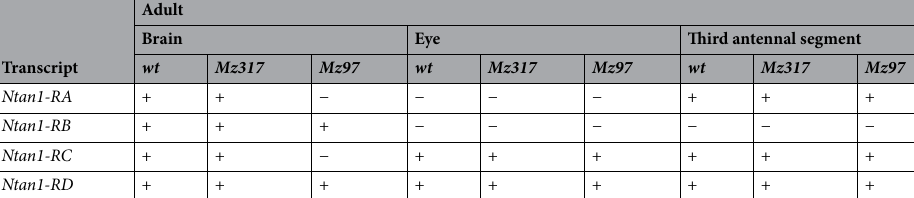
Table 3. Summary of the results obtained in the gene expression analysis by RT-PCR of the Ntan1 transcripts in different adult organs in different genotypes. The genotypes tested are: Canton-S (wt), Mz317-Gal4 (Mz317) and Mz97-Gal4,UAS-Stinger (Mz97). Negative symbol (−) indicates total absence of gene expression and positive symbol (+) indicates gene expression of the Ntan1